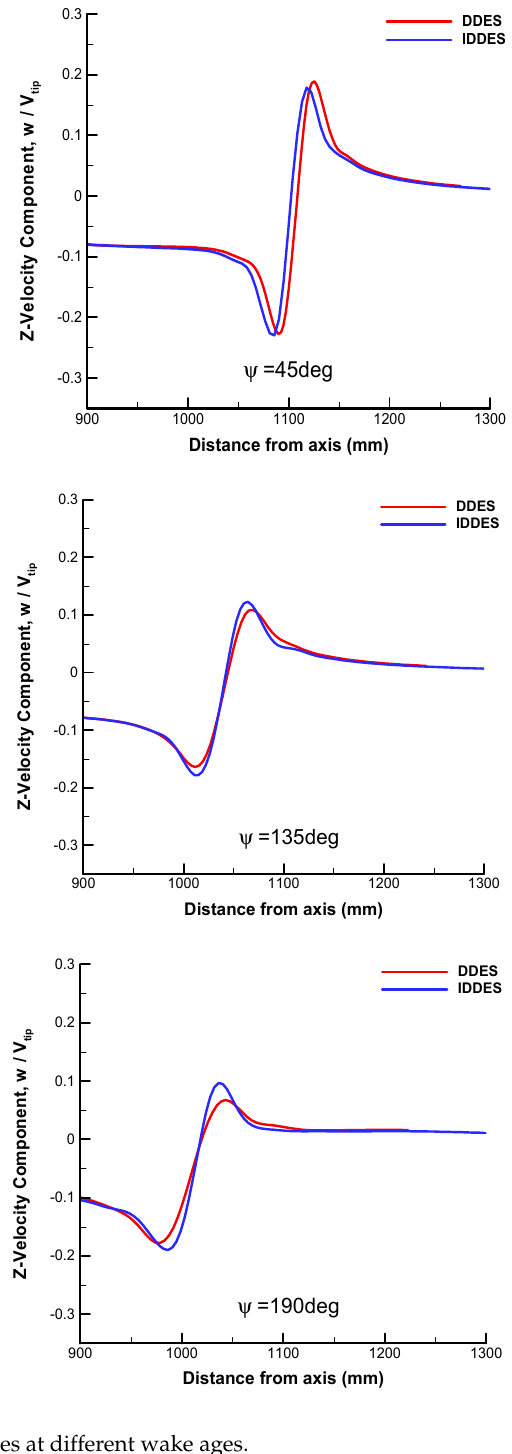
Figure 21. Comparisons of velocity profiles at different wake ages.